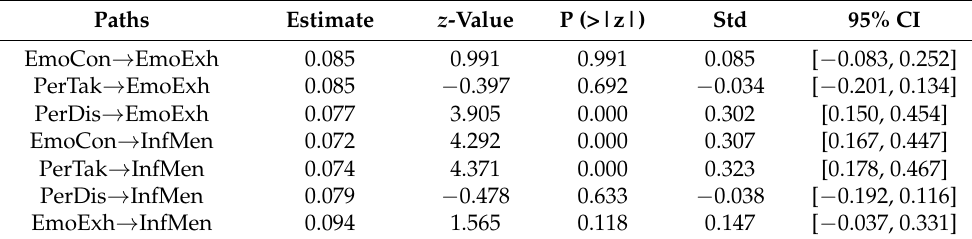
Table A1. Multiple mediation analyses model for direct effects from dimensions of empathy to emotional exhaustion through the inference of mental states.